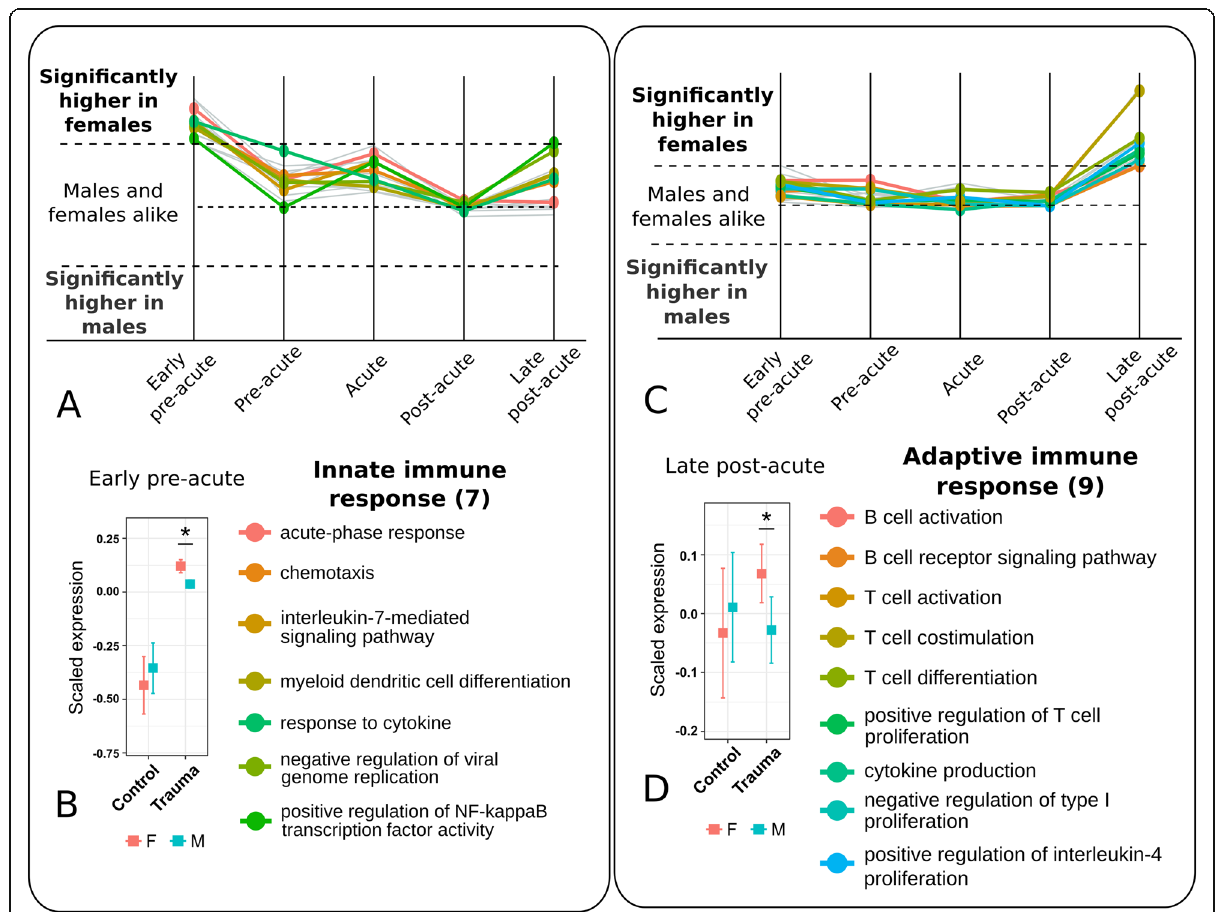
Fig. 2 Gene set clusters of the early pre-acute (left) and late post-acute phase (right). a The cluster of the early pre-acute phase consisted of 16 gene sets being upregulated in female patients. They comprised seven gene sets of the innate immune response. These gene sets are shown here. The complete list is given in Additional file 1: Fig. S5. b For the same phase, in comparison to healthy controls, leukocytes of both sexes showed a higher expression of genes for the innate immune response. A distinctively higher expression was observed in female patients. c Gene set clusters of the late post-acute phase consisted of 17 gene sets being upregulated in female patients, nine were related to the adaptive immune response. These gene sets are shown here. The complete list is given in Additional file 1: Fig. S12. d For the same phase, in comparison to healthy controls, leukocytes of female patients showed upregulation of the adaptive immune response. These gene sets were similarly expressed in male patients and healthy controls. The z-transformed expression values were referred to as ‘ scaled expression ’ values. Significance of difference between the expression of genes of male and female individuals was tested using two-sided Student ’ s t-tests (* P <0.05, mean bar and Whiskers of the boxplots: